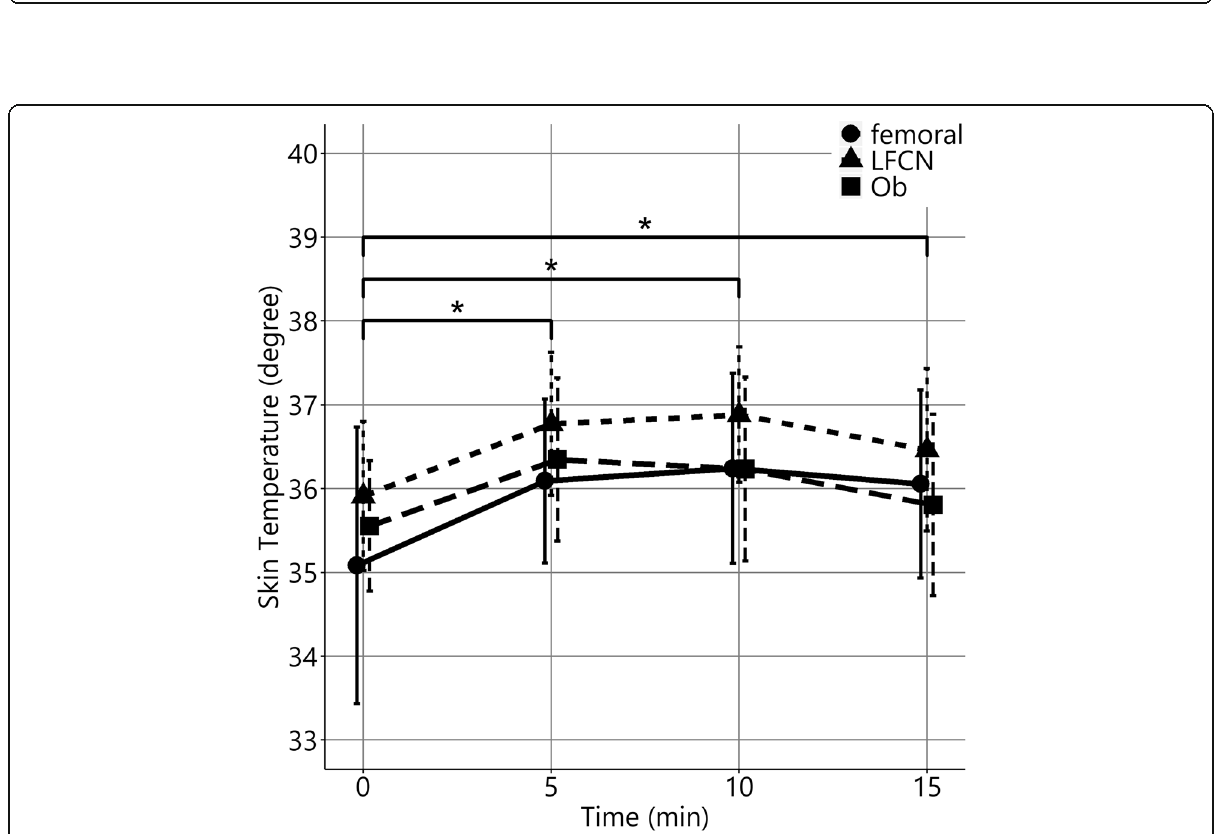
Fig. 3 Skin temperature at the femoral nerve, lateral femoral cutaneous nerve, and obturator nerve sites at baseline and at 5 min intervals after ultrasound-guided SFIB. Data are expressed as mean ± standard deviation of 20 experiments. * P < 0.01 compared with baseline including all data of the femoral, lateral femoral cutaneous, and obturator nerves site from 20 patients. LFCN, lateral femoral cutaneous nerve site; Ob, obturator nerve